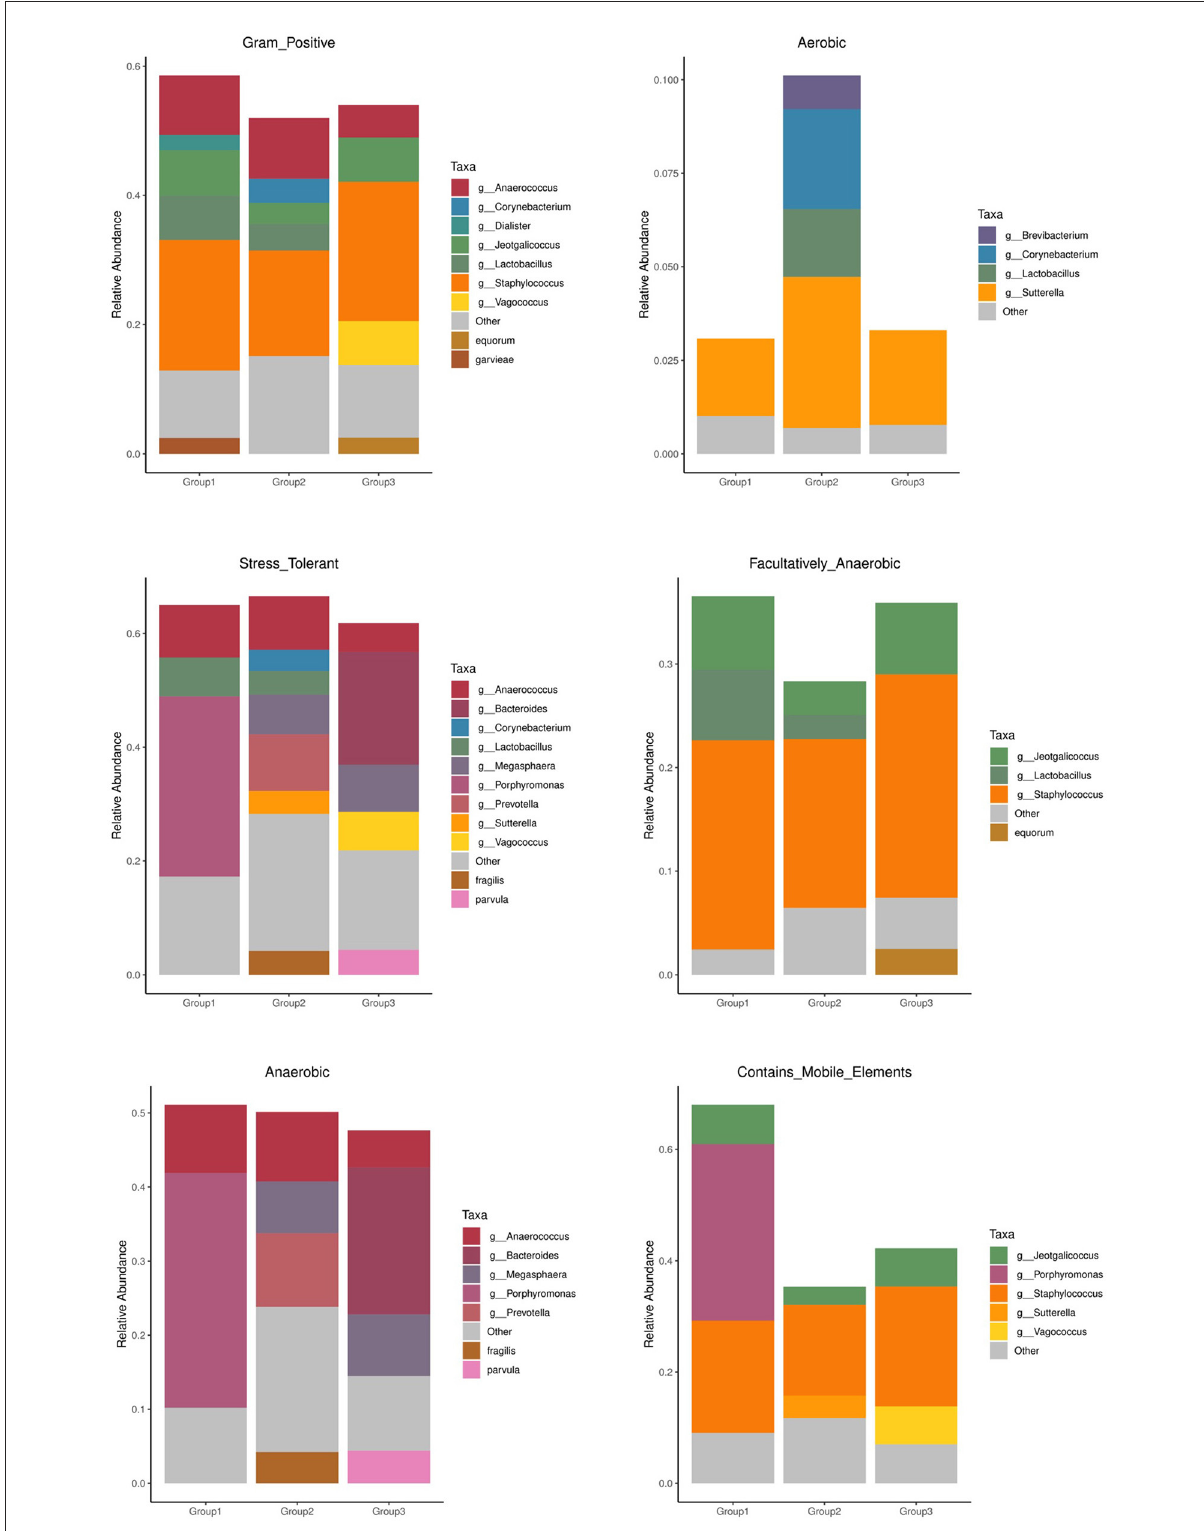
FIGURE7 Intrinsic factors associated with inter-individual variation in the gut